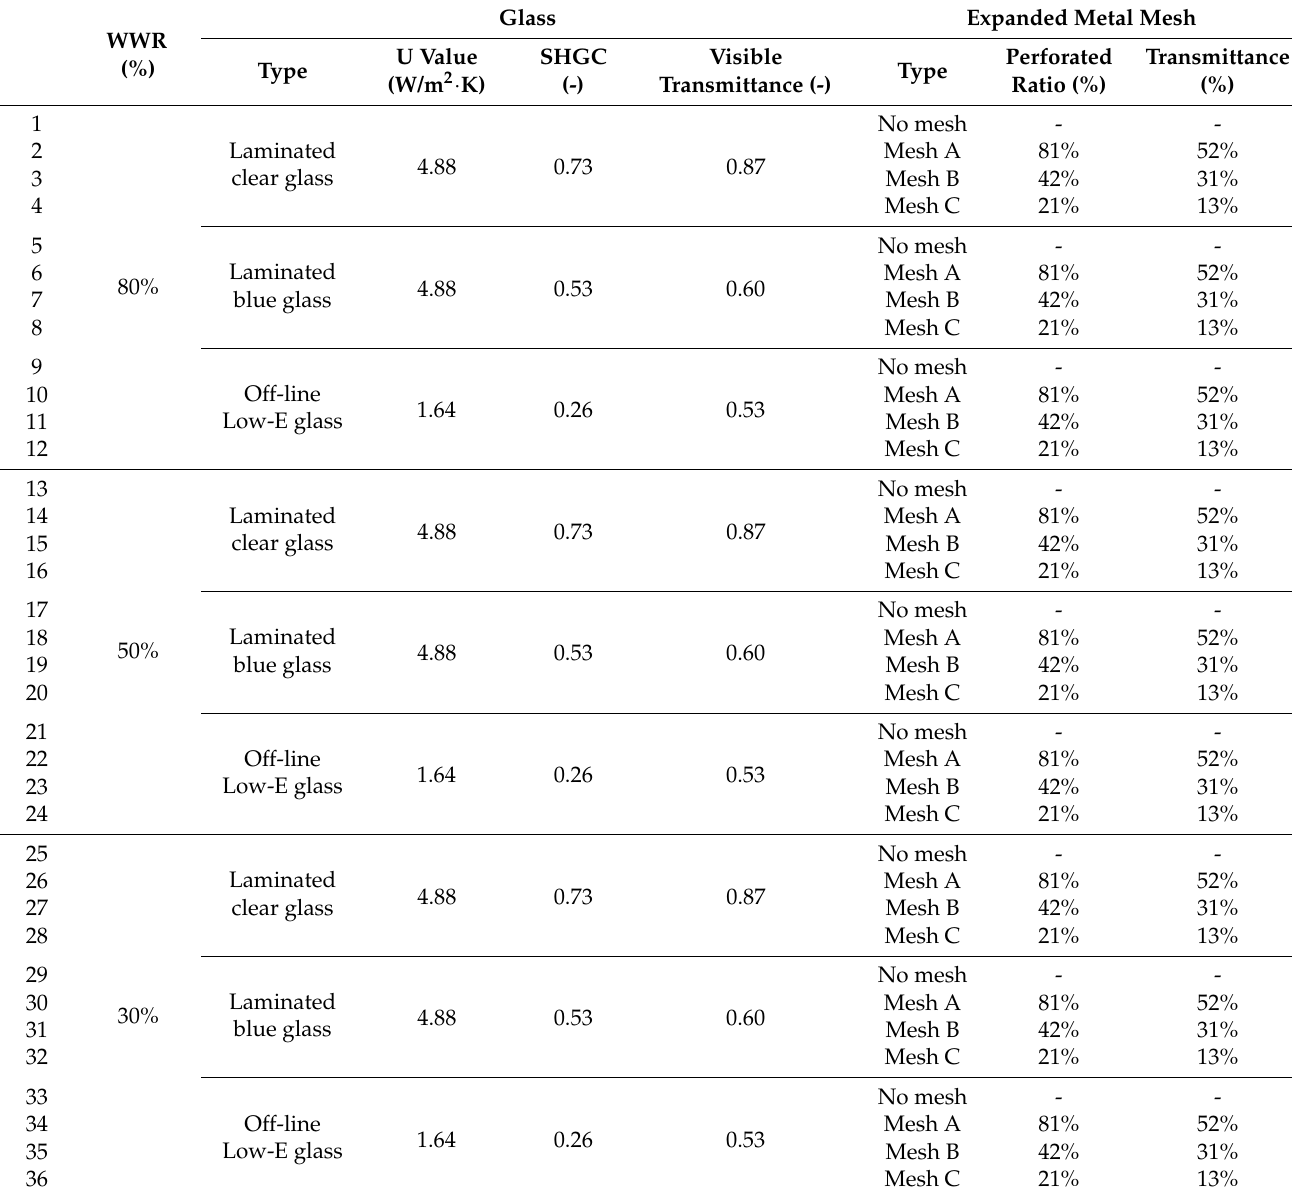
Table 5. List of simulation cases.